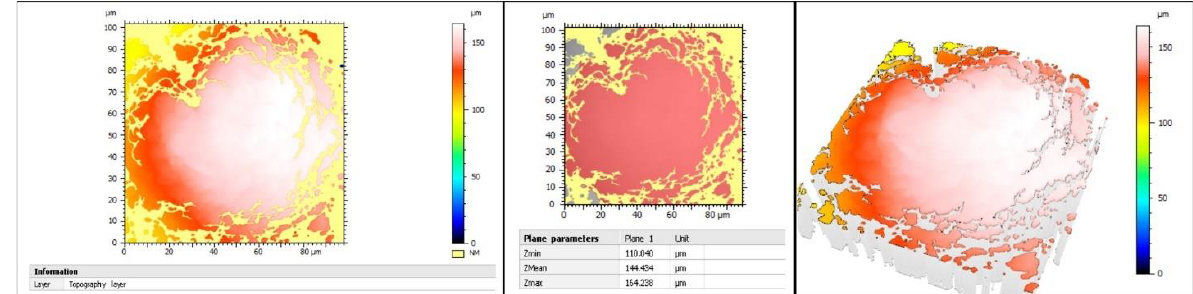
Figure 6. Lignin powder under the confocal microscope: ×5 ( top left ), ×10 ( top right ), ×20 ( bottom left ), ×50 ( bottom right ) .